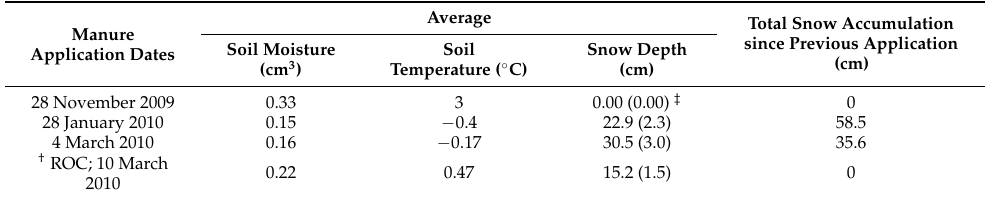
† ROC = start of the runoff collection date. () ‡ Values in parenthesis indicate water depth